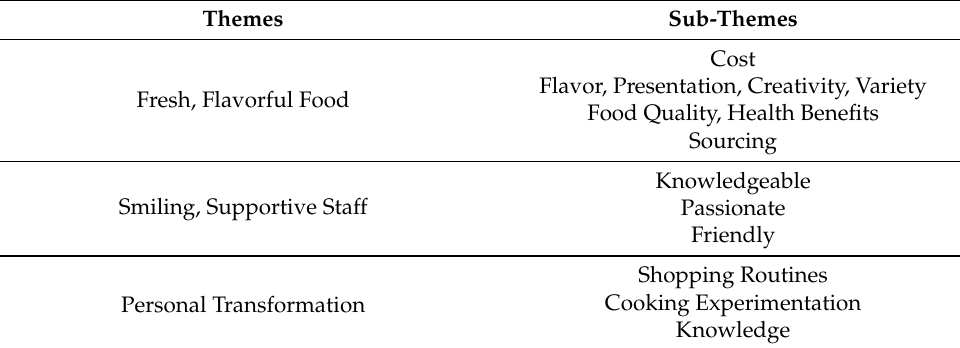
Table 2. Experiences described by Food Next Door (FND) customers (n = 10) in year